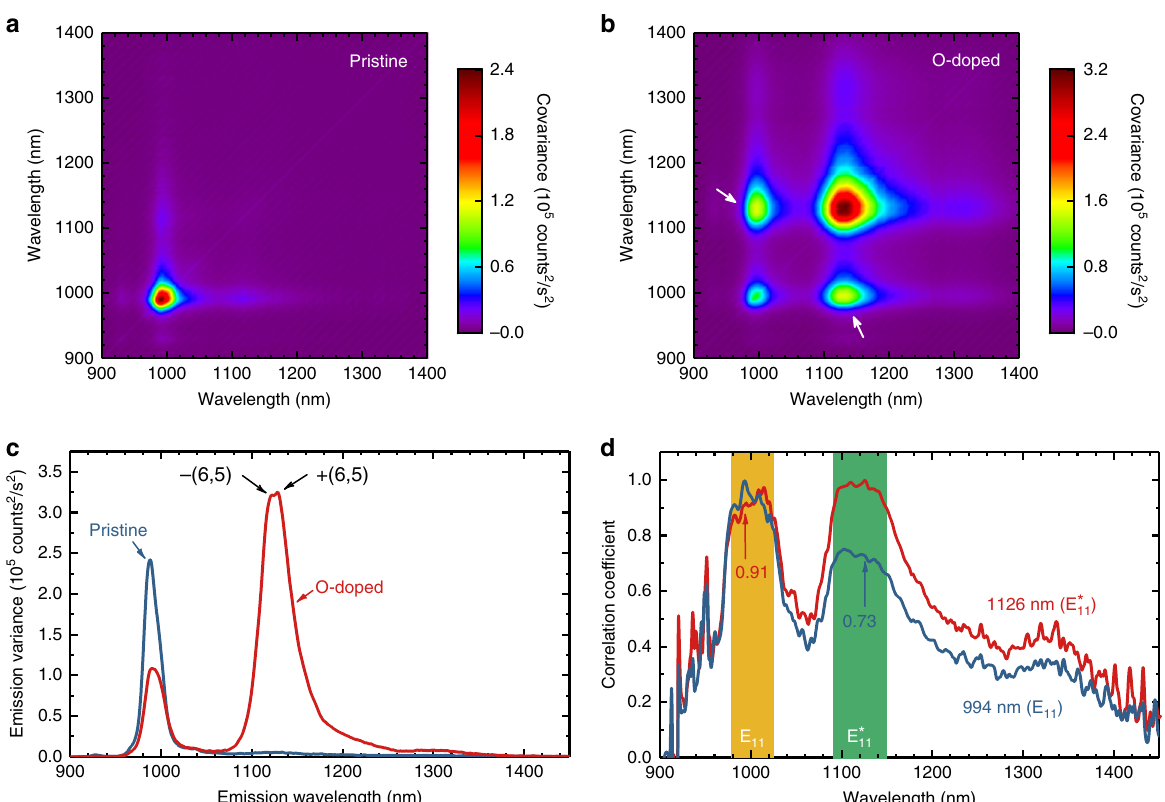
Fig. 4 Variance spectroscopy of pristine and O-doped (6,5)-SWCNTs. a Covariance matrix measured for the (6,5)-SWCNT suspension before treatment. b Covariance matrix measured for the (6,5)-SWCNT suspension after treatment. The off-diagonal components (white arrows) reveal the presence of correlated E 11 and E (cid:1) emissions. c Variance spectra (diagonal traces) of frames ( a ) and ( b ). The O-doped trace shows evidence of spectrally resolved E (cid:1) 11 peaks from the two (6,5) enantiomers. d Pearson correlation coef fi cient spectra, at 994 and 1126 nm, of the O-doped (6,5)-SWCNT imaged through optical fi lters to isolate the E (cid:1) emission. High 11 contrast images displaying clear vascular and lymphatic structure